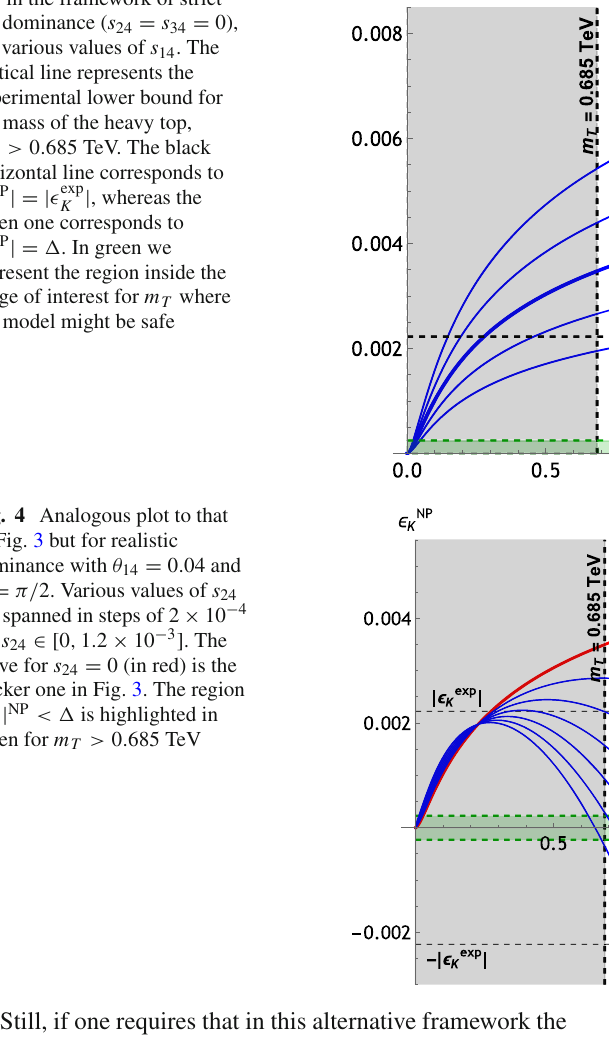
| as a function of Fig. 3 | (cid:3) NP K m T in the framework of strict s 14 dominance ( s 24 = s 34 = 0), for various values of s 14 . The vertical line represents the experimental lower bound for the mass of the heavy top, m T > 0 . 685 TeV. The black horizontal line corresponds to | (cid:3) NP | = | (cid:3) exp | , whereas the K K green one corresponds to | (cid:3) NP | = (cid:12) . In green we K represent the region inside the range of interest for m T where the model might be safe